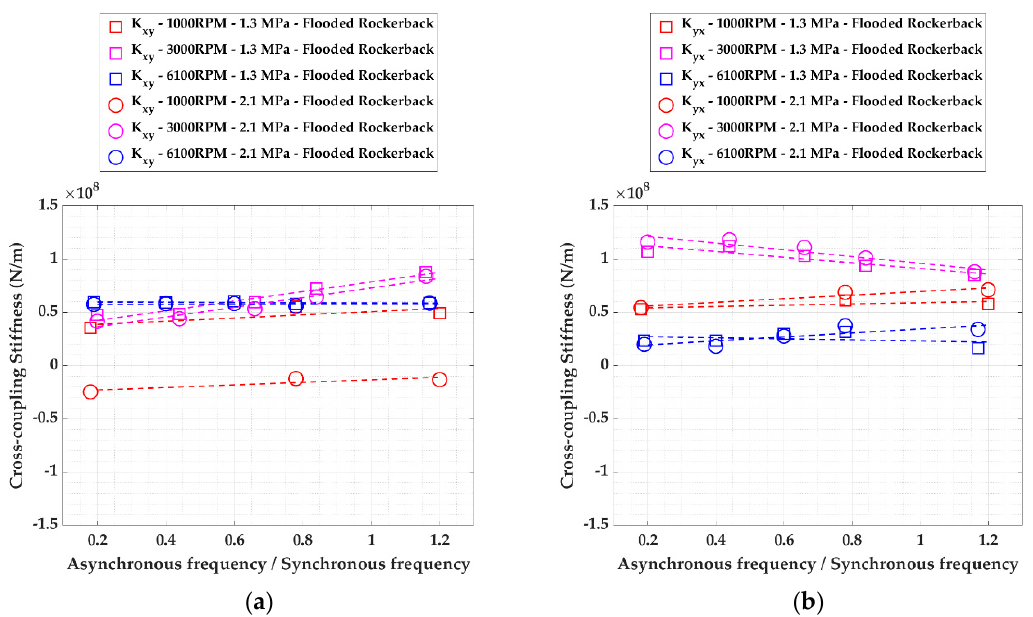
Figure A6. Flooded Rocker Pivot bearing asynchronous cross-coupling coefficients at various speeds for 1.3 MPa and 2.1 MPa: ( a ) K xy , ( b ) K yx .